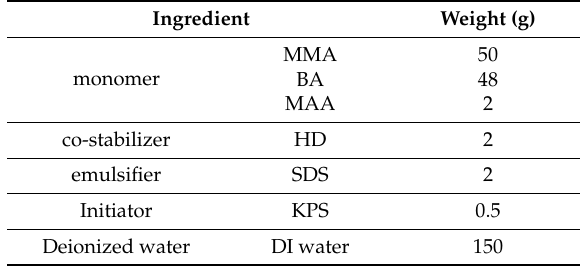
Table 1. Recipe for emulsion polymerization. MMA—methyl methacrylate; BA—butyl acrylate; MAA—methacrylic acid; HD—hexadecane; SDS—sodium dodecyl sulfate; KPS—potassium